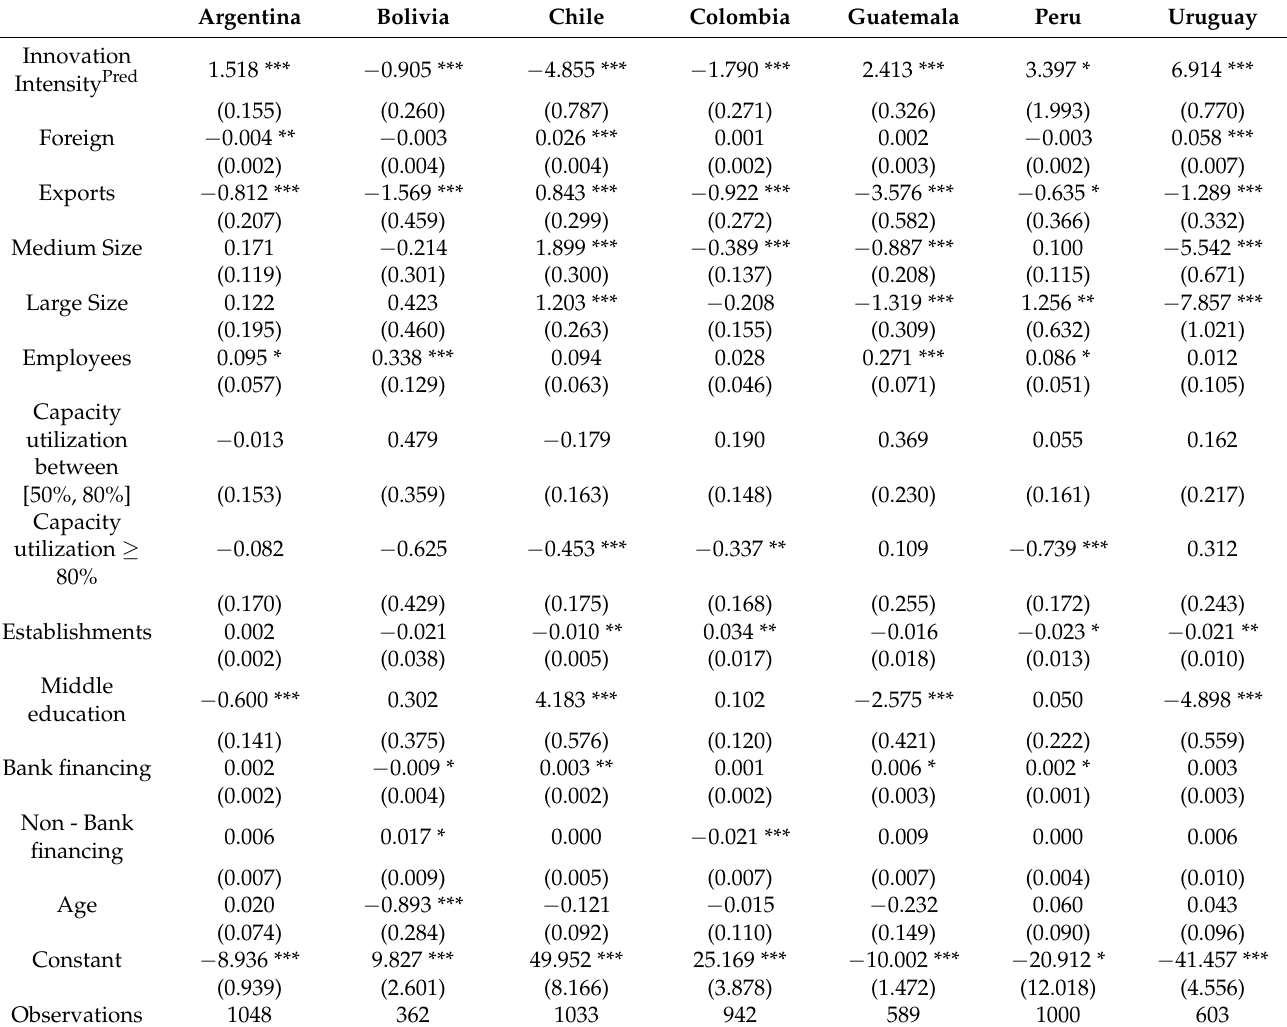
Table 10. Probability of the introduction of process innovations stage 3 CDM